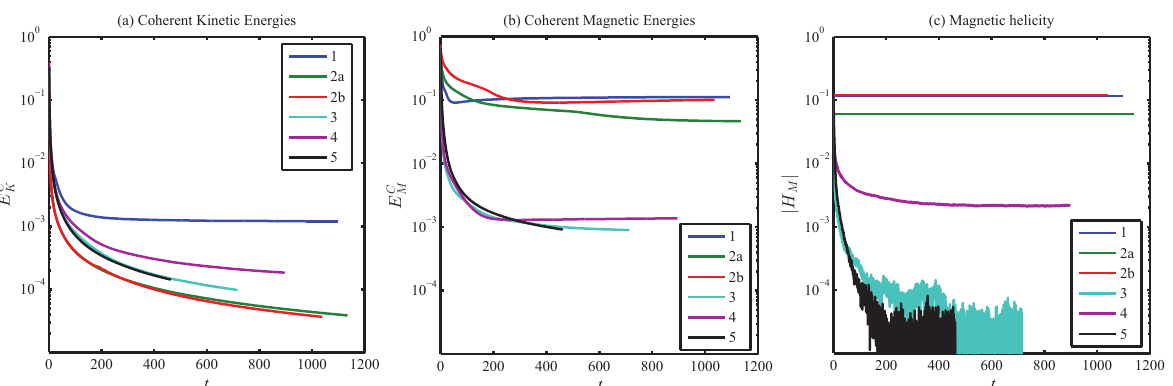
Figure 5. Magnetic energies for the k = 1 modes versus time t for Runs ( a ) 3 and ( b ) 5. In these runs, = 0 so that H M is not an invariant, although H P is an invariant in Run 4 where Ω o = σ B o B o (cid:54) is an invariant in Run 4 where Ω o = σ B o Run 5, B o is not aligned with Ω o , and the only invariant is E . The ensemble prediction for both ( a , b ) P is 2 10 − 7 , so the relatively very large and steady values during transition are anomalous. ×